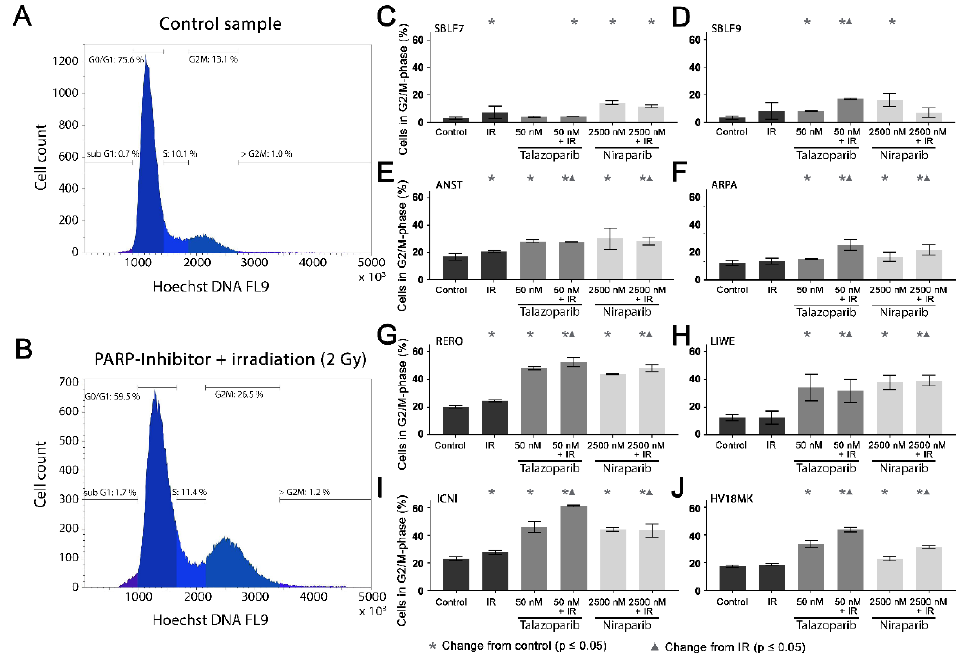
Figure 3. G2/M phase arrest after combined PARPi plus IR treatment. The G2/M phase content of healthy skin fibroblast and melanoma cell cultures. The DNA content was analyzed by flow cytometry of Hoechst 33342 staining 48 h after the treatment with IR, with a PARPi (50 nM Talazoparib respectively 2500 nM Niraparib) or with IR plus an inhibitor. The control groups stayed untreated. ( A ) Histogram of the cells in the different cell cycle phases of a control sample. ( B ) A sample after a combined treatment of PARPi plus IR. ( C–J ) G2/M phase fraction in eight different cell cultures. The data were analyzed using the Mann–Whitney-U test. (All %-values and p -values of cell cycle are included in the supplementary material Table S4-S6)